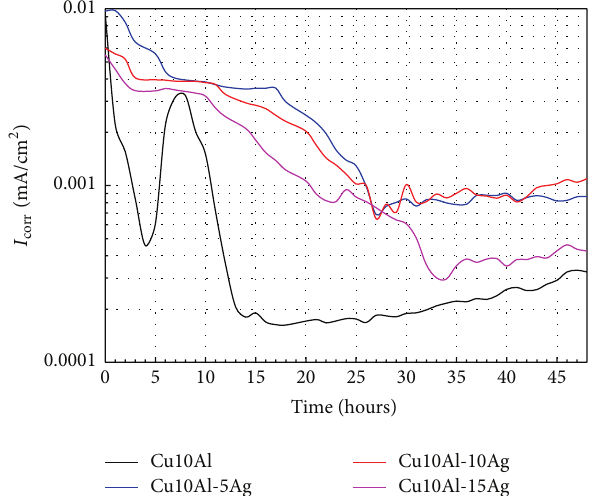
Figure 8: Change of 𝐼 corr values with time for the Cu10Al- 𝑥 Ag alloys in artificial saliva at 37 ∘